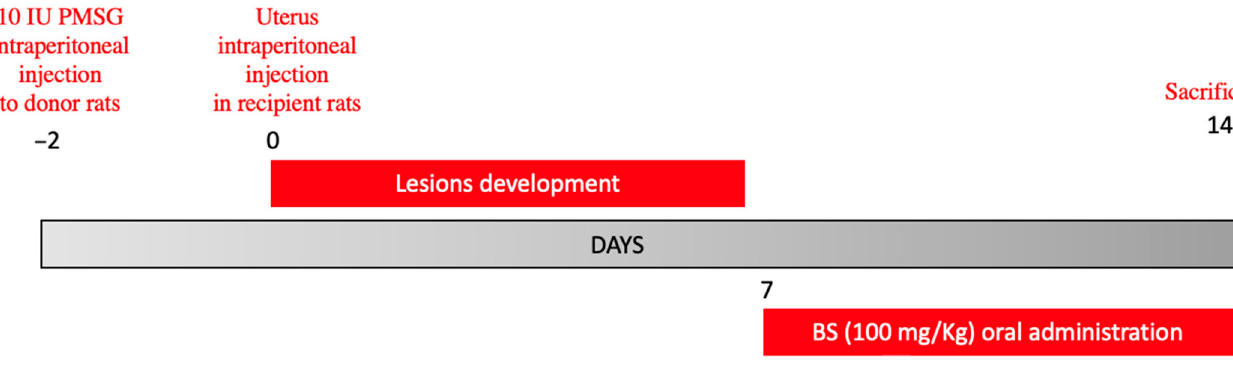
Figure 7. Study design figure.